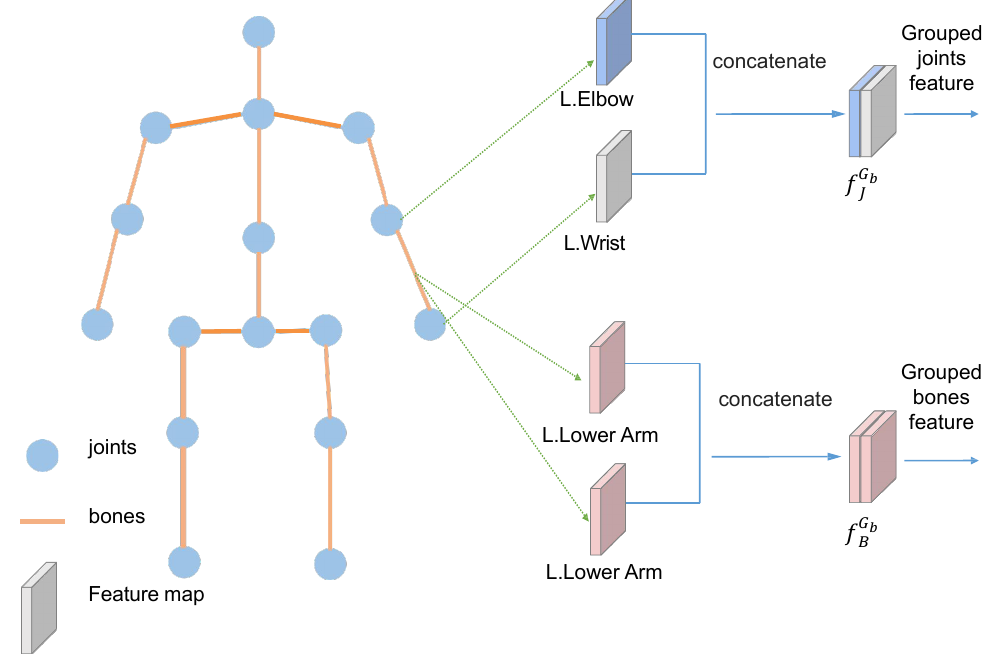
Figure 4. Illustration of the proposed feature